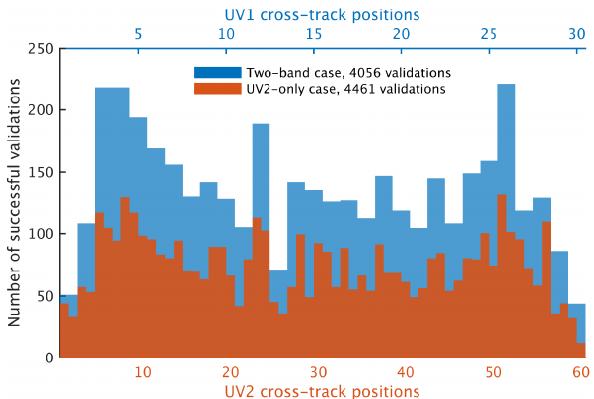
Figure 8. Number of successful validations at different cross-track positions for the two-band case (blue) and UV2-only case (red) over